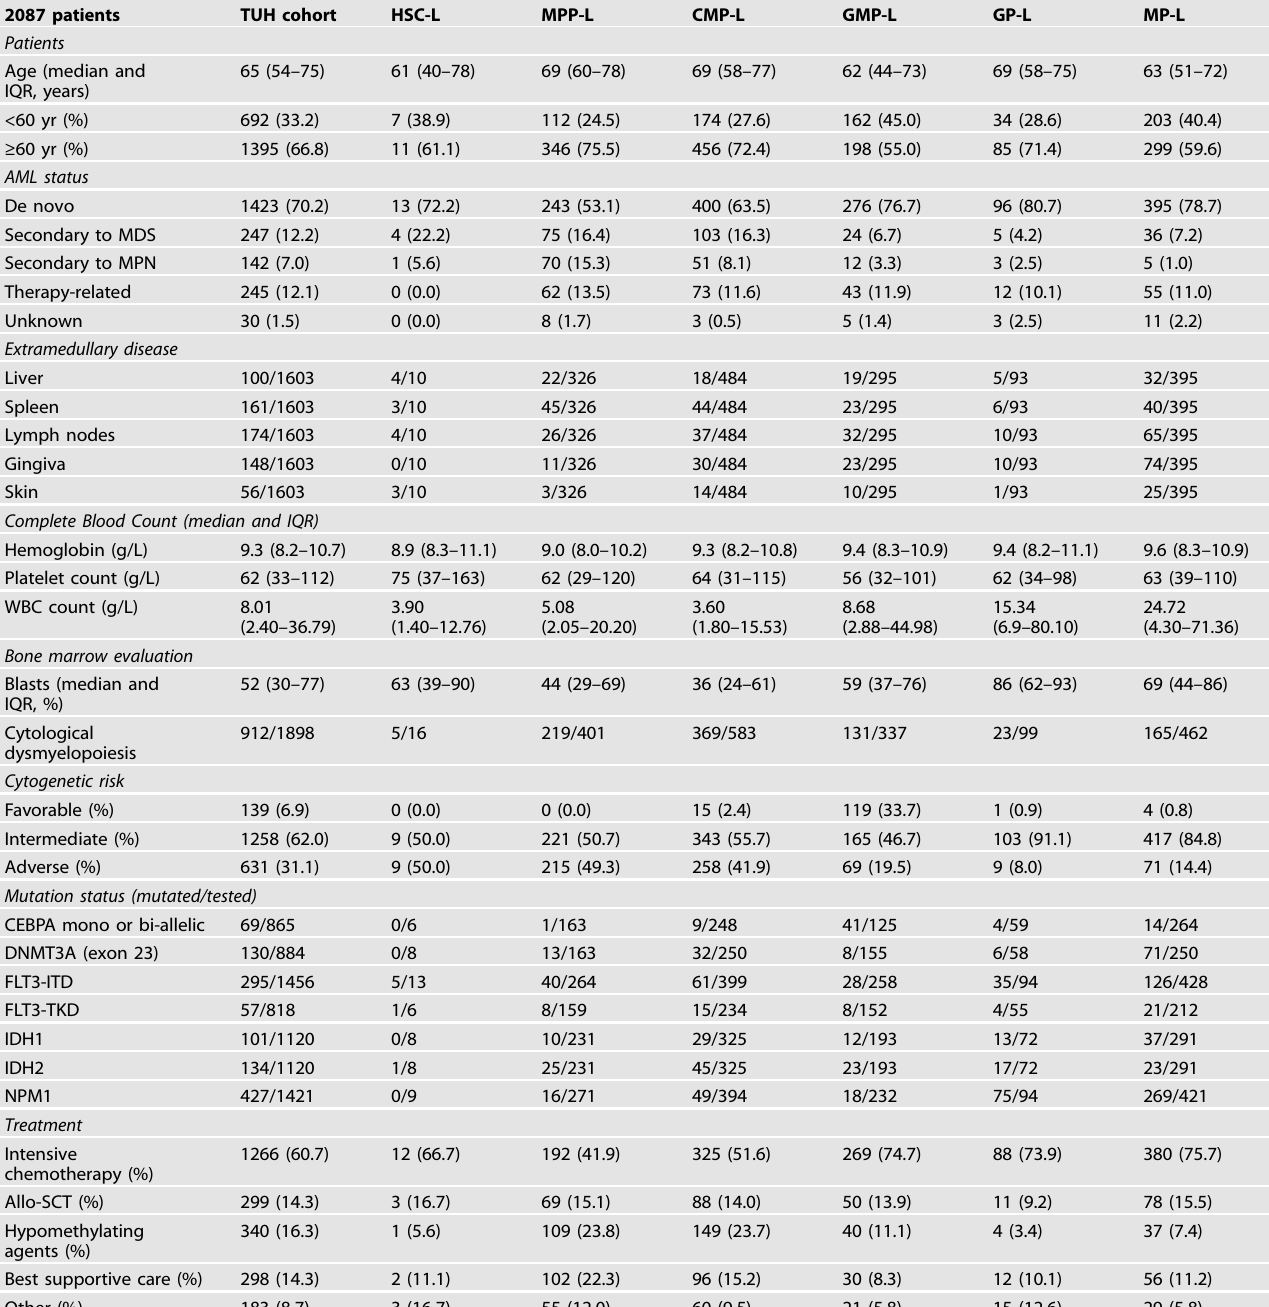
Table 1. Characteristics of patients from the TUH